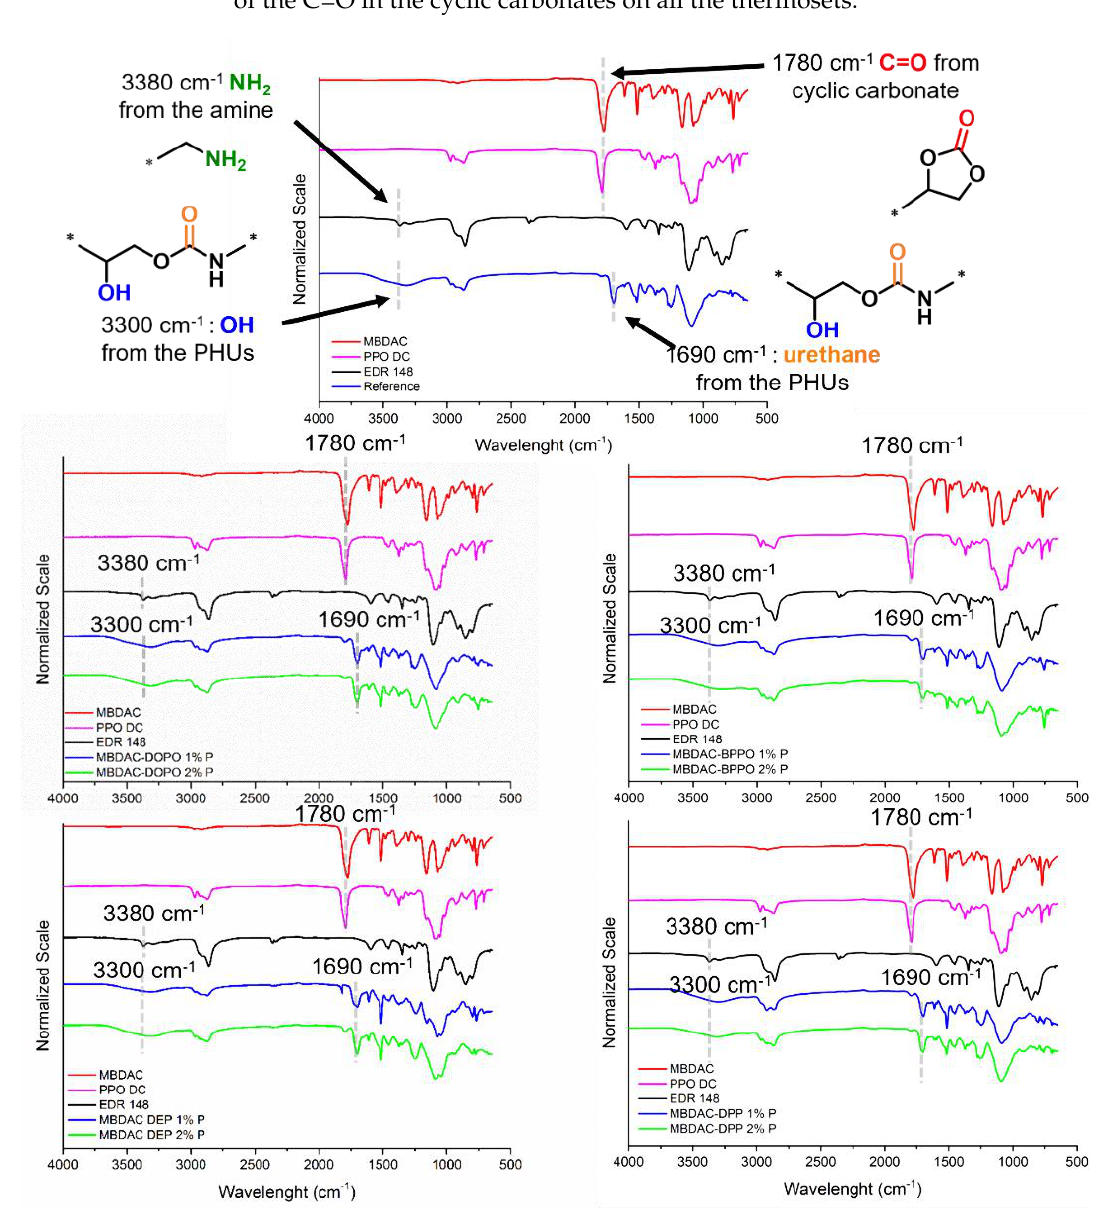
Figure 1. FTIR spectra of the different formulations.